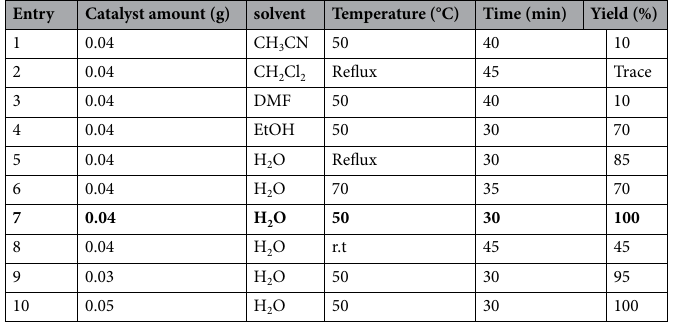
Table 1. Optimization conditions for reduction of nitro aromatic compounds. Bold indicates the optimal values of the reaction